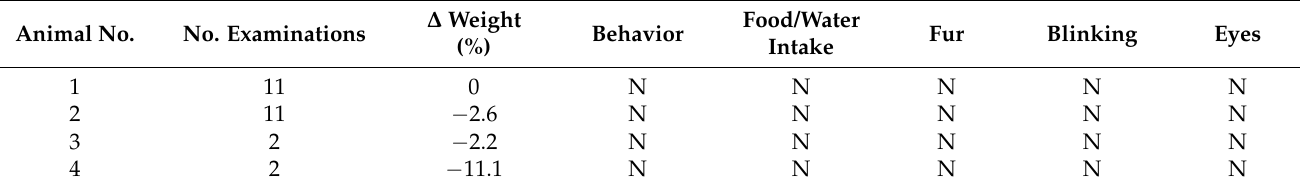
Table 1. Welfare of treated rabbits. Rabbits nos. 1 and 2 were monitored for 90 d while nos. 3 and 4 were sacrificed at 7 d. The weight was determined weekly. Behavior, food and water intake, condition of fur (groomed and shiny), eyes (clear, no redness, swelling or discharge), and frequency of blinking (qualitatively) evaluated weekly and any anomalies were noted. The shown ∆ weight refers to the change from day 0 to 7. N = normal.